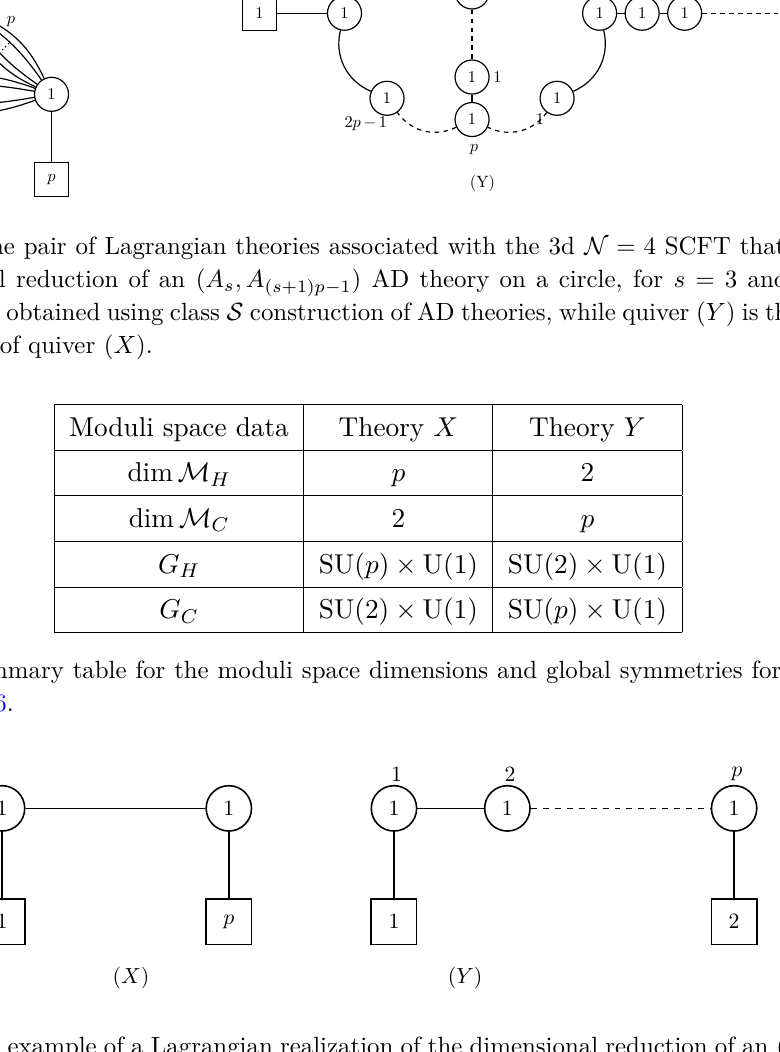
Figure 36 . An example of a Lagrangian realization of the dimensional reduction of an ( A 1 , D 2 p +2 ) theory is given by the quiver ( Y ) for generic p